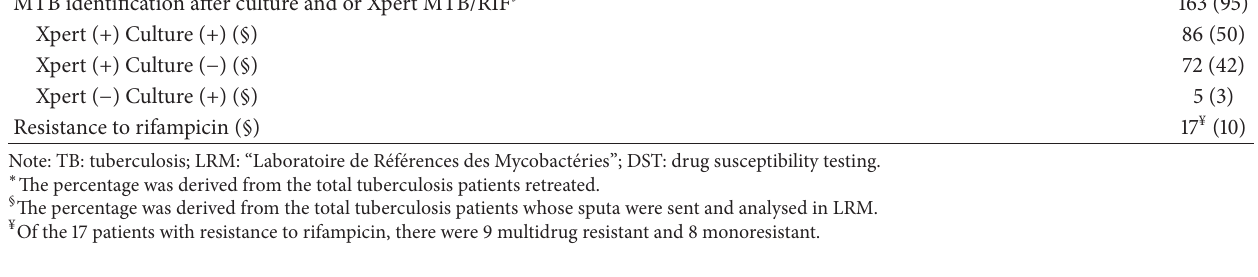
Table 4: Retreatment tuberculosis patients, drug susceptibility testing achieved, and bacilli sensitivity to rifampicin, Benin, 2013. Total retreatment TB patients 241 Patients whose specimens were sent to the LRM for DST tests ( ∗ )